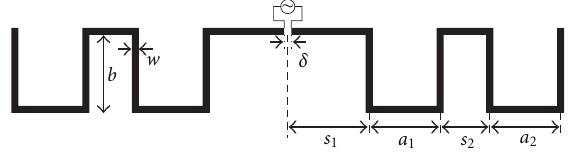
Figure 1: Geometry of the meander-line antenna for c =